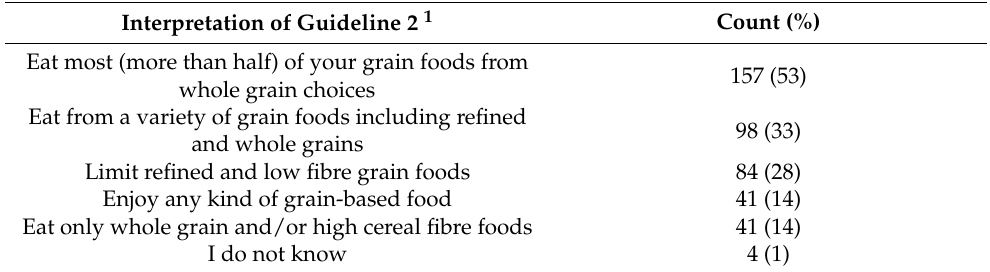
Table 5. Respondents’ interpretation of the focus of Guideline 2 for whole grain intake (n = 295)